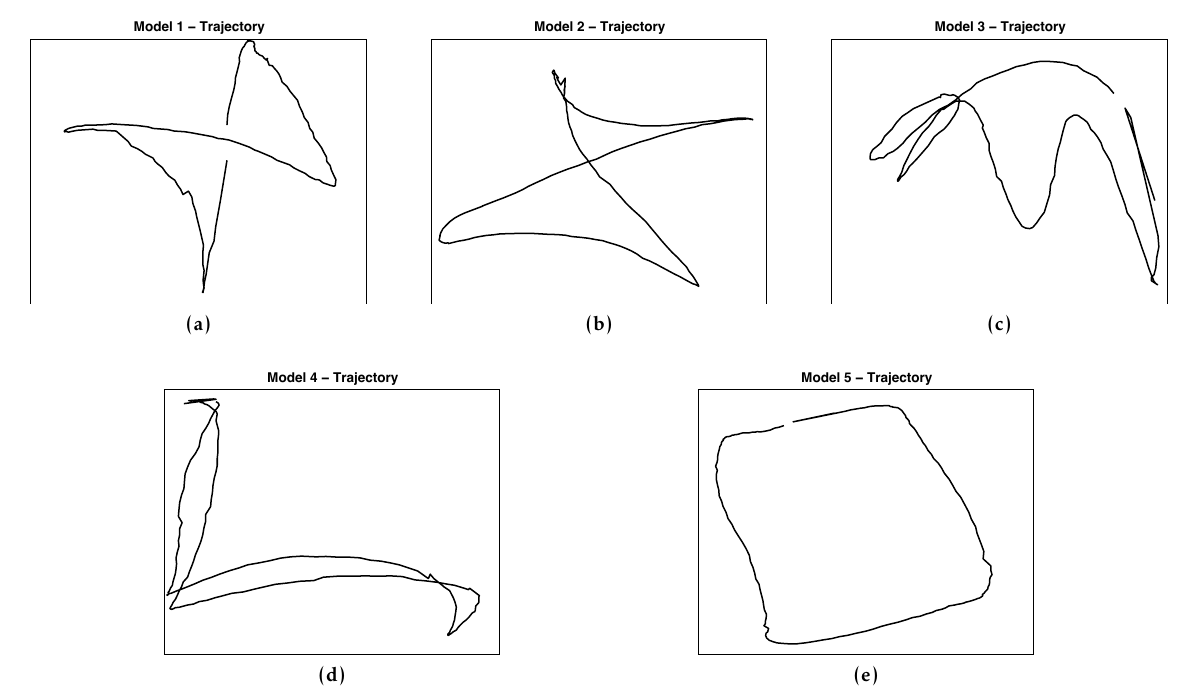
Figure 1. Spatial configuration of the five conductor models with 4/4 time